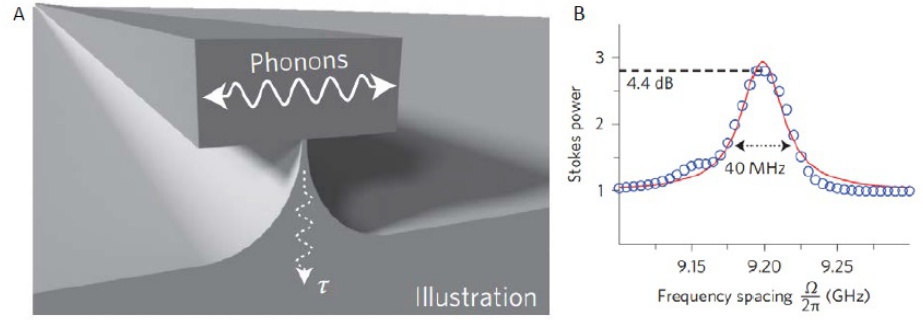
Fig. 26. Phonon-photon coupling in a silicon photonic waveguide. (a) Illustration of the partially underetched waveguide. (b) The on/off gain of a detuned signal by a 35 mW